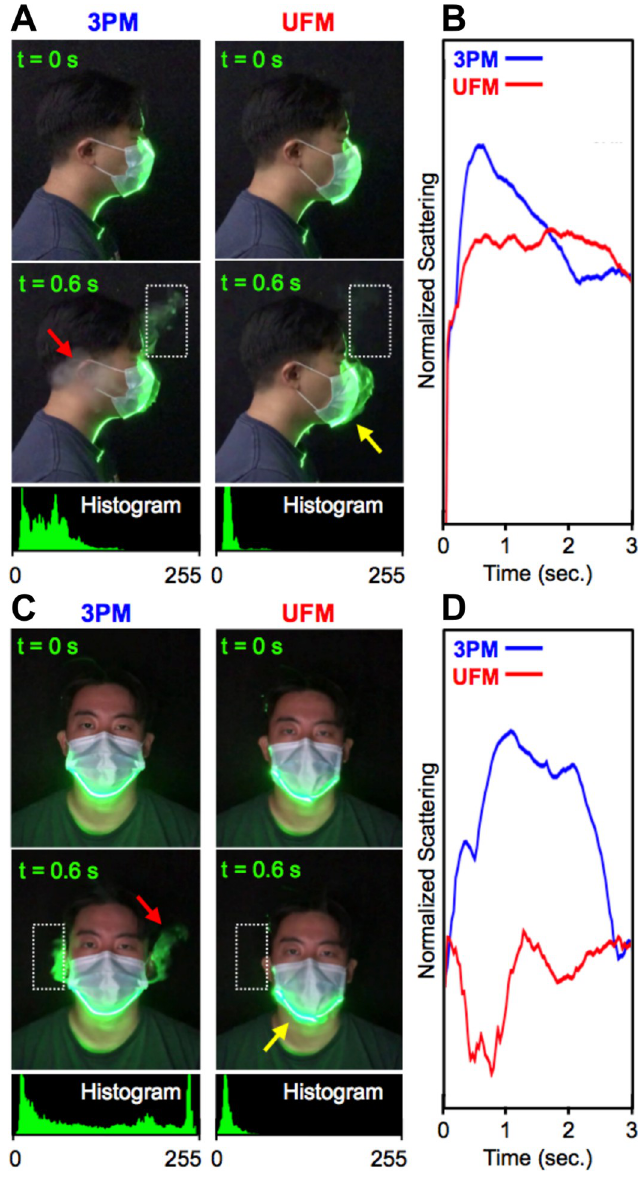
Fig 2. Evaluation of exhaled vapor using laser scattering. (A, C) Side-view and front-view exhaled vapor imaging and histograms of the segmented area (white dotted box). Red arrows indicate particles that escaped the mask, while yellow arrows indicate particles that passed through the mask filter material. (B, D) Normalized laser scattering of the segmented forehead and lateral regions over an exhalation